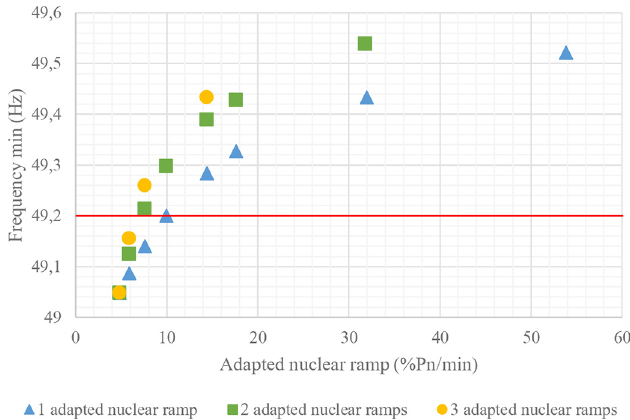
Fig. 11. Dip frequency as a function of the adapted nuclear ramp for 125 MW solar RE power